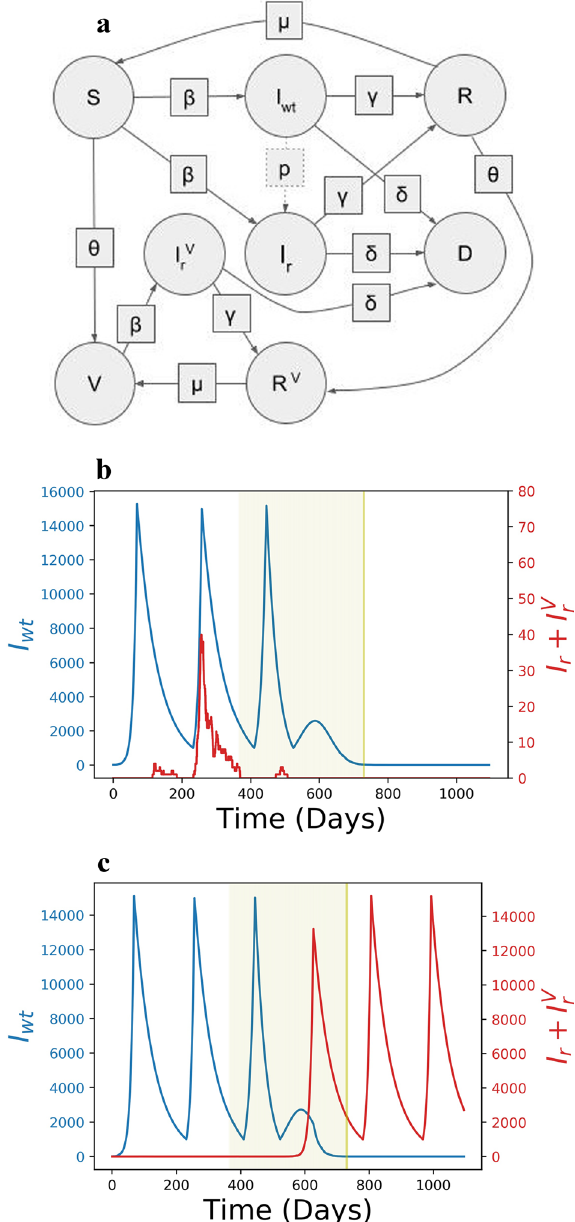
Figure 1. The states, transition parameters and dynamics. ( a ) States are shown in circles and transition parameters in squares. The transition parameter, μ , is the rate at which individuals lose natural immunity and p , is the probability that an individual infected with the wildtype strain transmits a resistant strain, so it is not a deterministic parameter. Example dynamics of the number of individuals infected with the wildtype (blue) and resistant strains (red) for p = 10 – 6 , θ 0 = 1 / 365 and F h = 15,000. The period of vaccination is highlighted (green). Under the same parameters the resistant strain may emerge and go extinct, ( b ), or become established, ( c